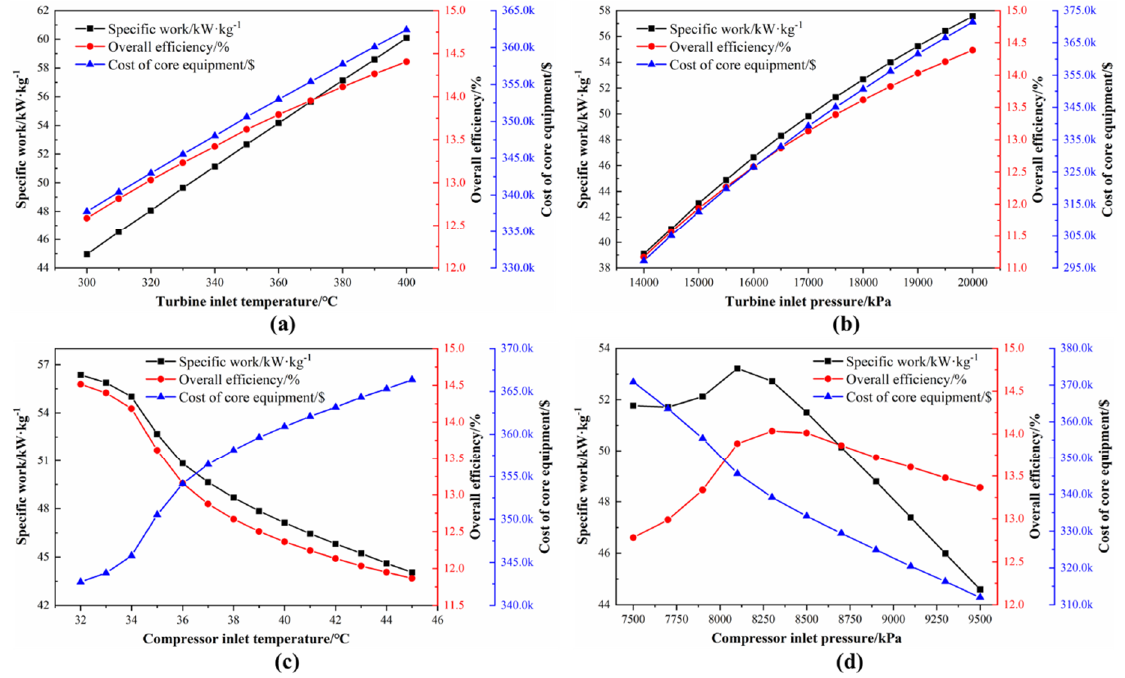
Figure 8. Effects of the turbine inlet temperature ( a ), turbine inlet pressure ( b ), compressor inlet temperature ( c ), and compressor inlet pressure ( d ) on specific work, overall efficiency, and cost of core equipment (intercooling cycle).